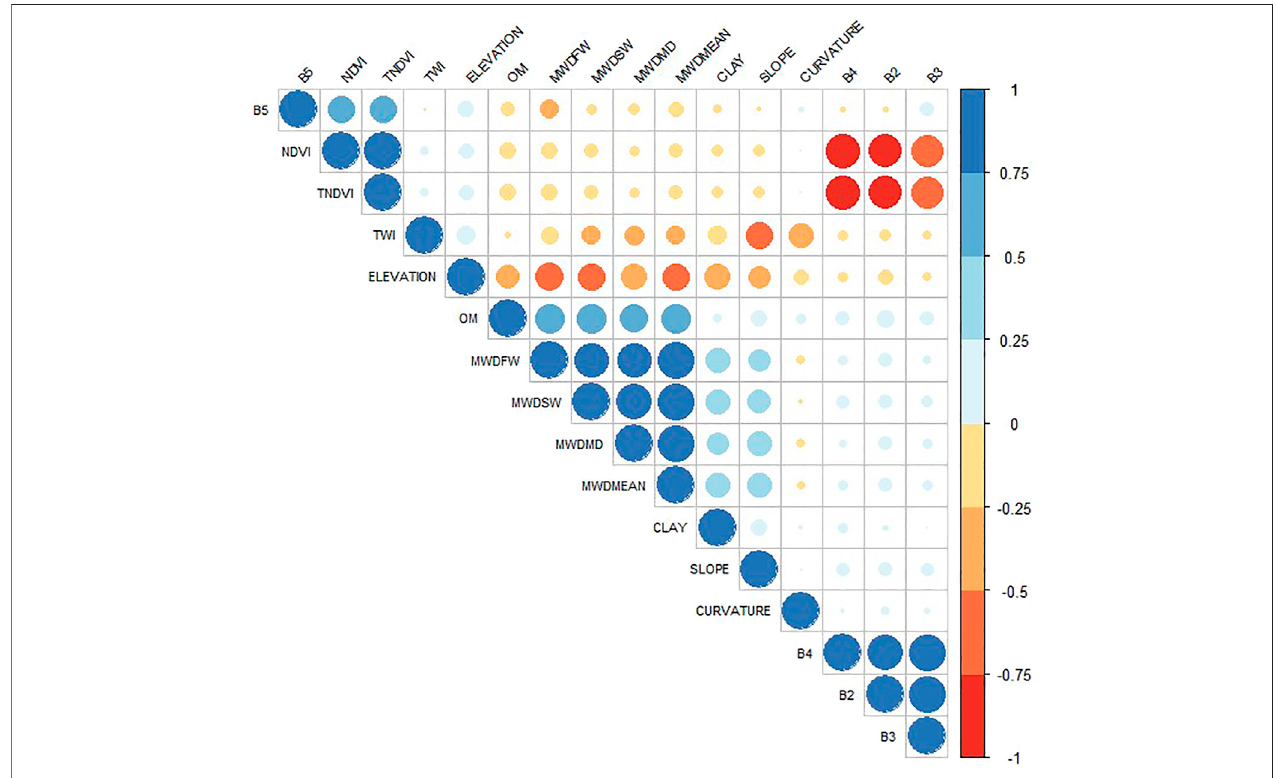
FIGURE 5 | Heatmap correlations showing the relationships between investigated variables. MWDmb, mechanical breakdown; MWDsw, slow wetting; MWDfw, fast wetting; MWDmean, the mean of the three tests; OM, organic matter; NDVI, normalized difference vegetation index; TNDVI, transformed normalized difference vegetation index; B2, Band 2; B3, Band 3; B4, Band 4; B5, Band 5 and TWI, topographic wetness index.